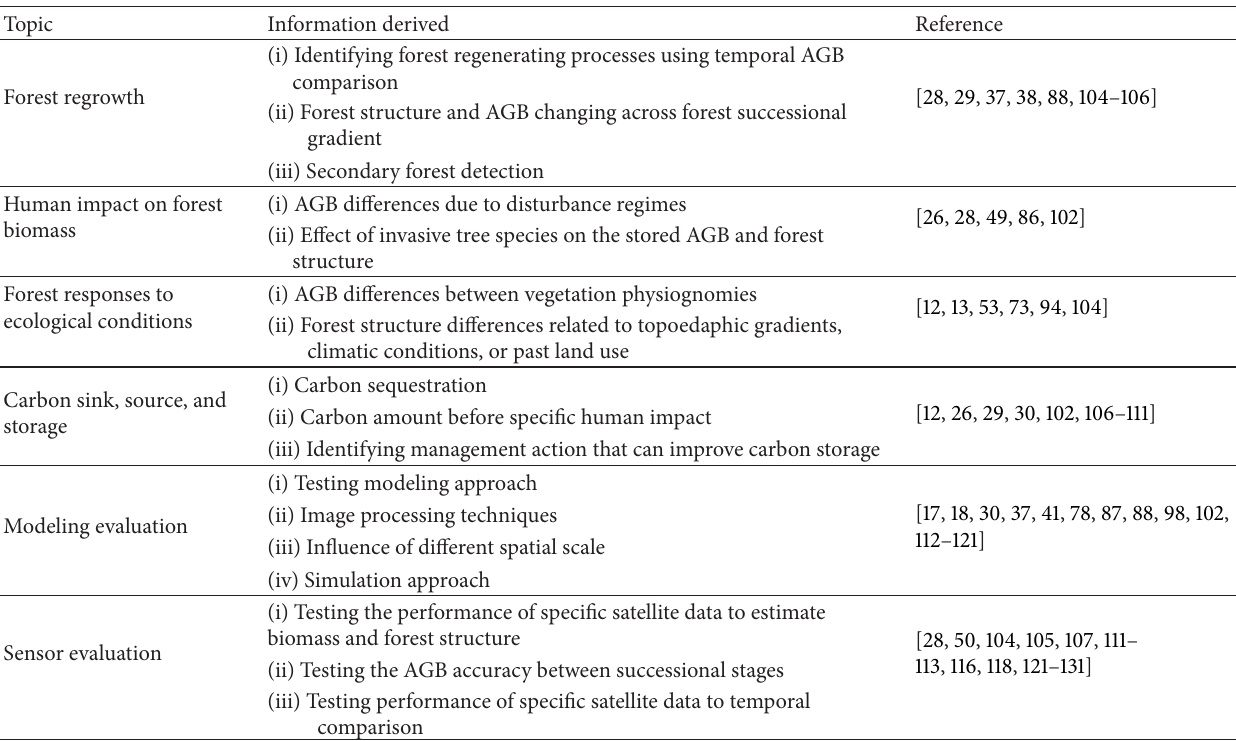
Table 1: Major issues discussed in the reviewed references and the information derived from the aboveground biomass (AGB) estimation by using remote sensing